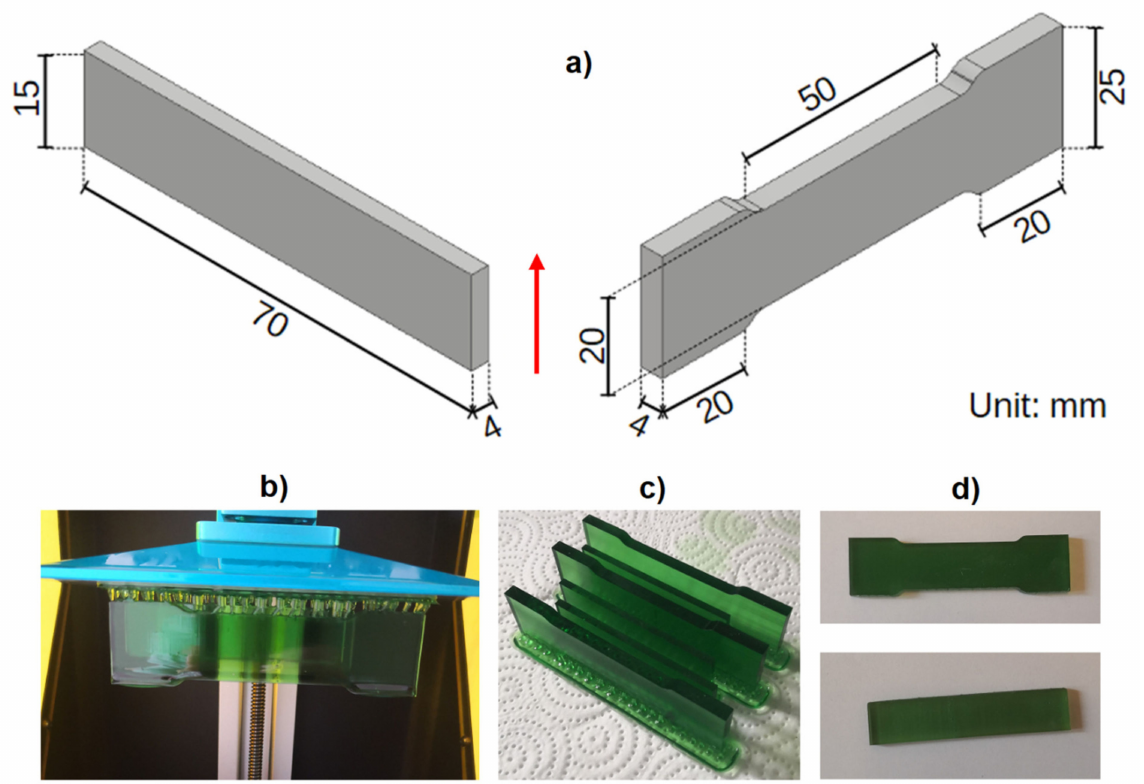
Figure 1. Printed specimens: ( a ) shape and dimensions, the red arrow shows the direction of the layer growth during printing, ( b ) the specimen after printing, ( c ) the specimens after post-process washing, ( d ) the specimens after